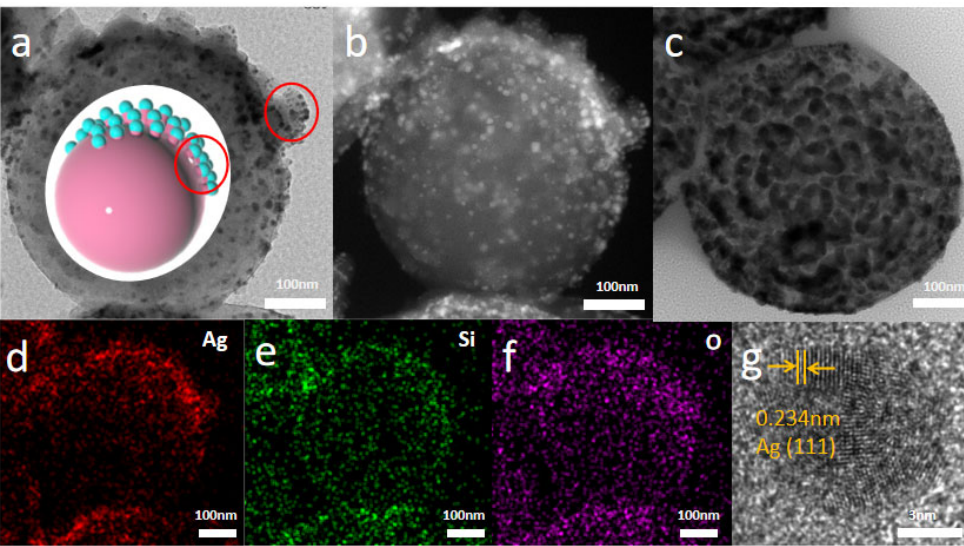
Figure 3. TEM and HRTEM image of samples etched for 30s ( a , b , g ) and the corresponding mapping images ( d – f ) of EDX elements (Ag, Si, and O). TEM image of samples etched for 60s ( c ).